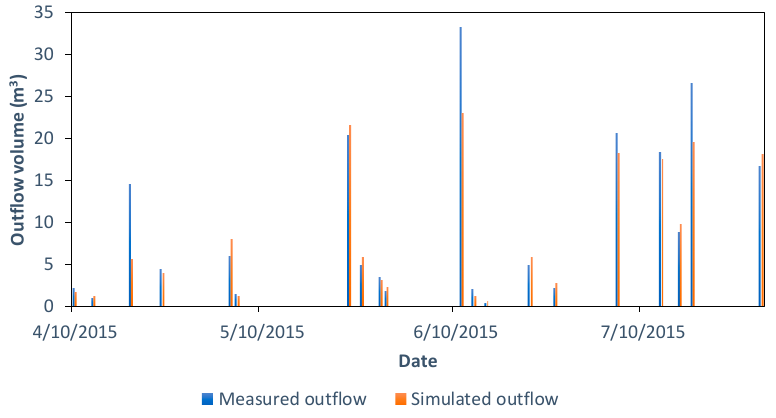
Figure 16. Measures versus simulated outflow volume.